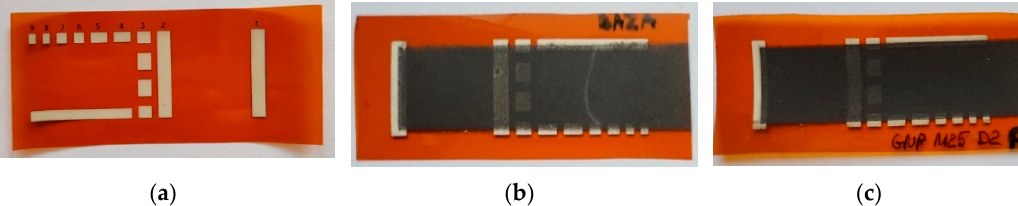
Figure 2. Kapton film substrates ( a ) without a layer; ( b ) with the layer made with the base ink with a visible agglomerate; and ( c ) with the homogeneous layer made with an ink with 5% surfactant content.